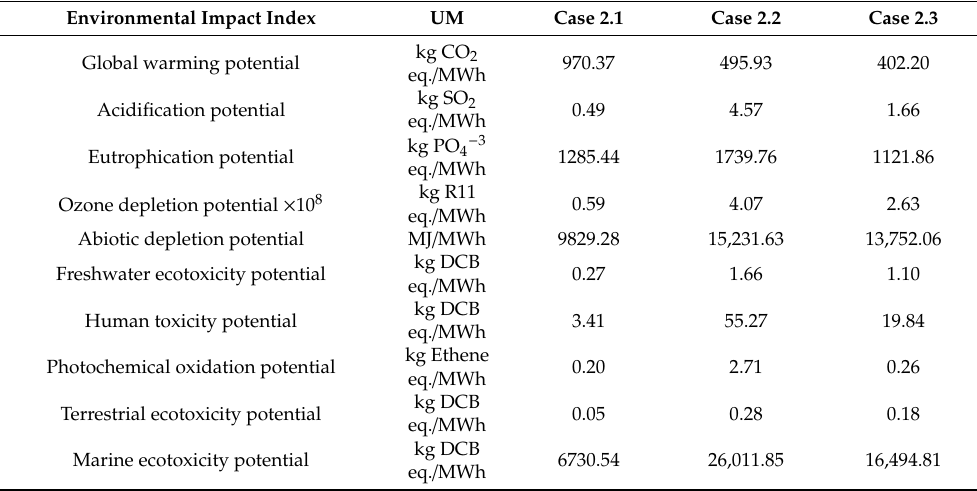
Table 4. Environmental impact indicators (Life Cycle Analysis) for super-critical power